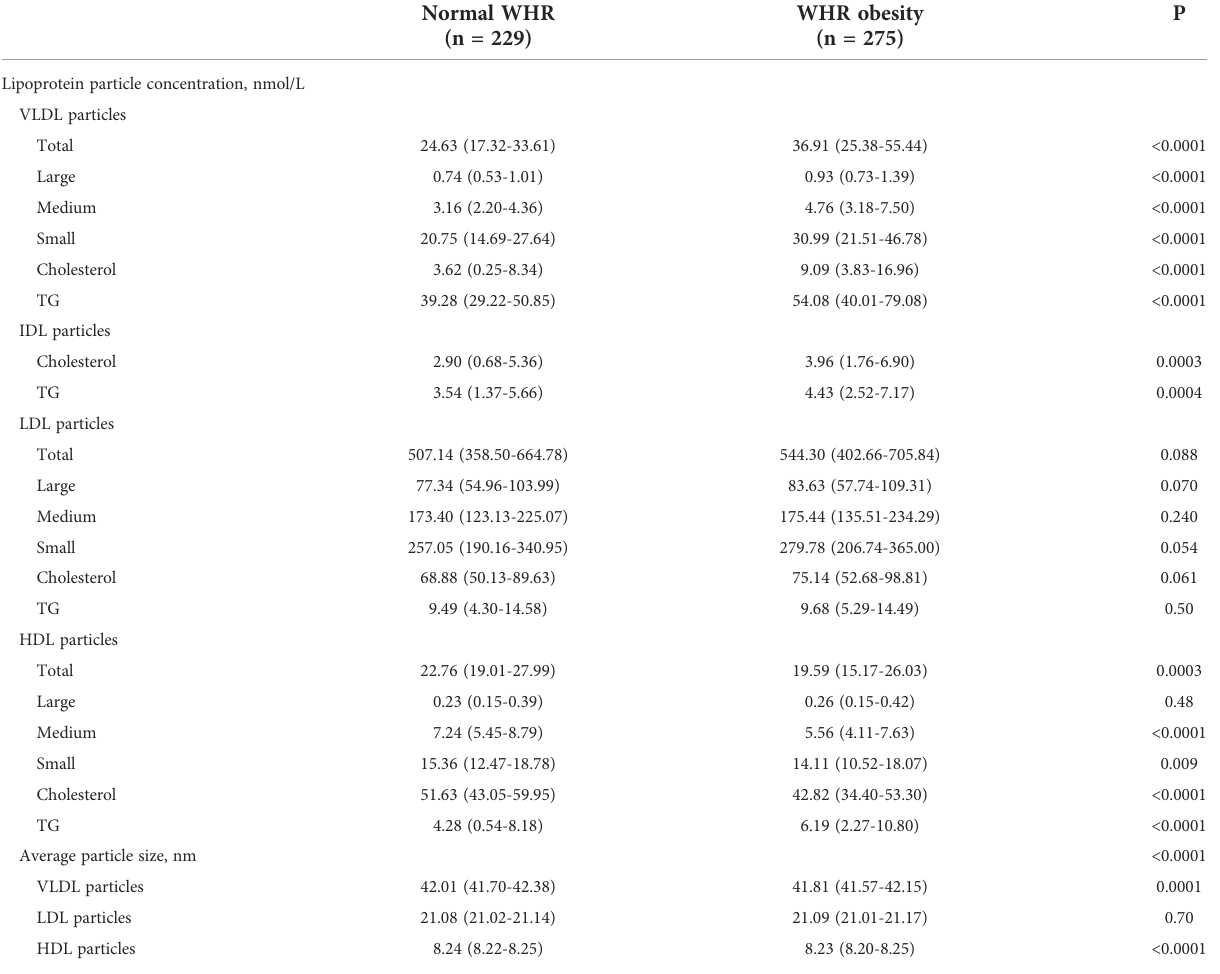
TABLE 2 NMR spectrometry-measured lipoprotein particle concentration and